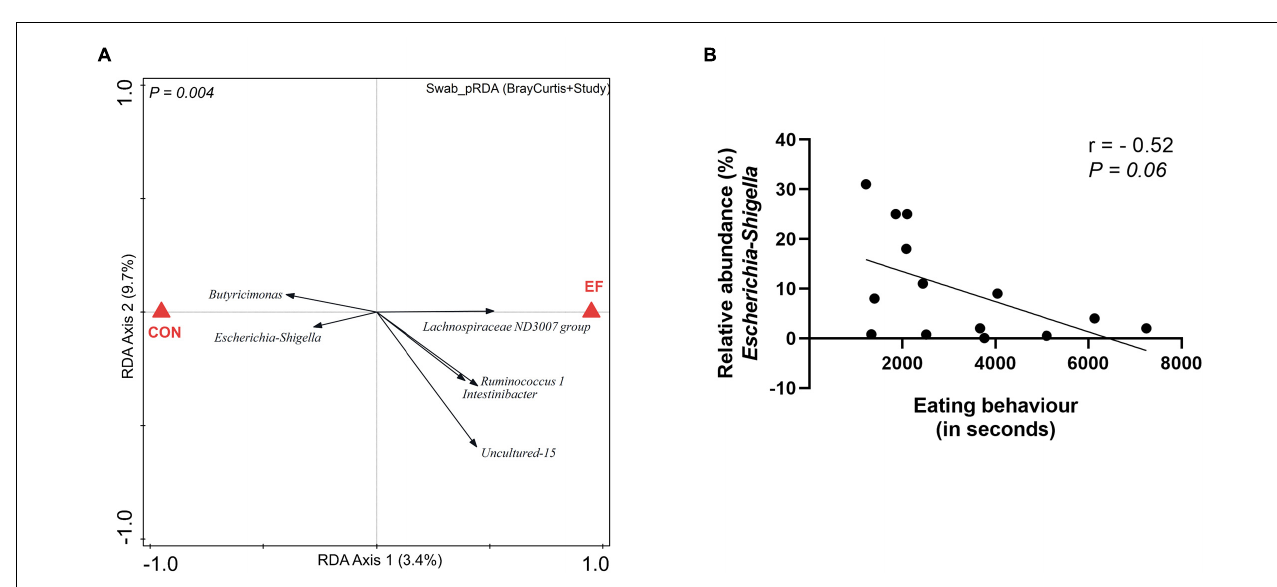
FIGURE 2 | Impact of nutritional intervention on mucosa-adhered population. (A) Partial redundancy analysis (pRDA) of the dietary intervention (EF vs. CON) employing the rectal swab microbiota data from both the animal experiments, corrected for the variable distance (squared Bray Curtis) to their paired colon microbiota and the variable “study” (adjusted explained variation = 2.46%; P = 0.004). (B) Spearman correlation between eating scores of EF piglets and the relative abundance of Escherichia-Shigella in the rectal swab (experiment 1).